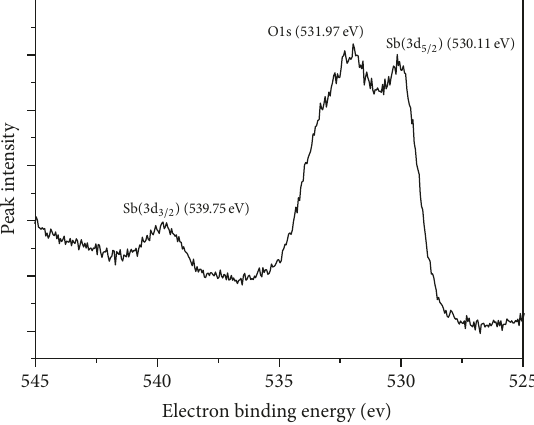
Figure 14: The spectrum of Sb3d and O1s after adsorption.